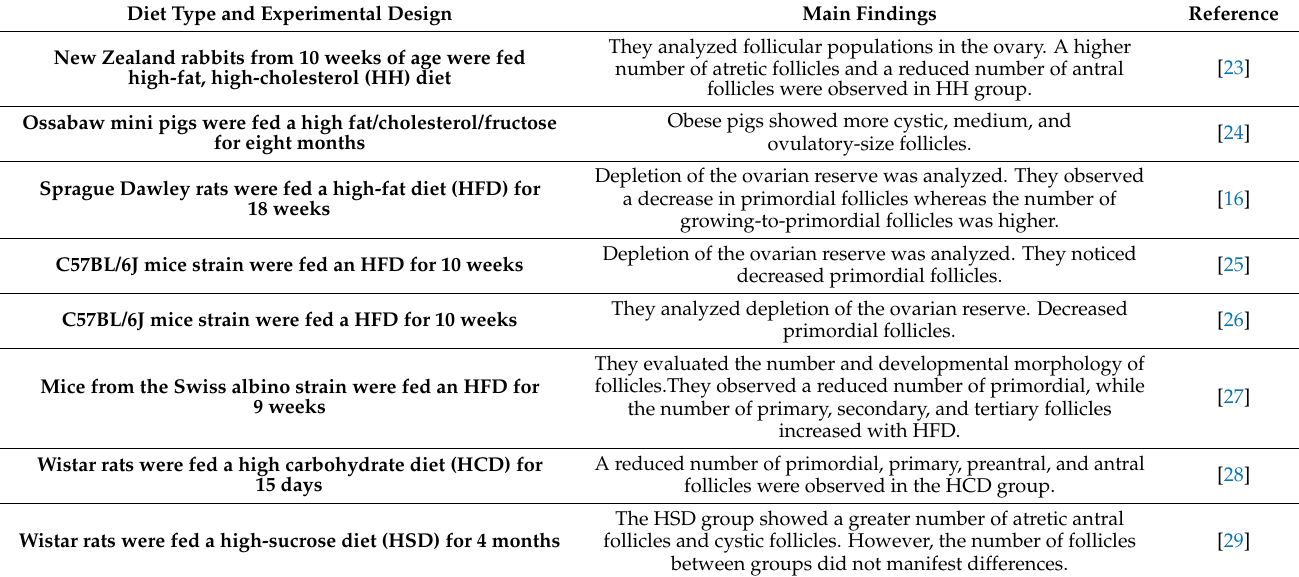
Table 1. Types of diets and their effects on the follicular